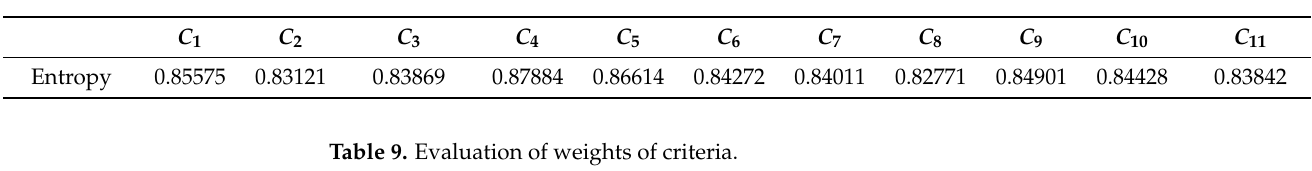
Table 8. Evaluation of entropy.